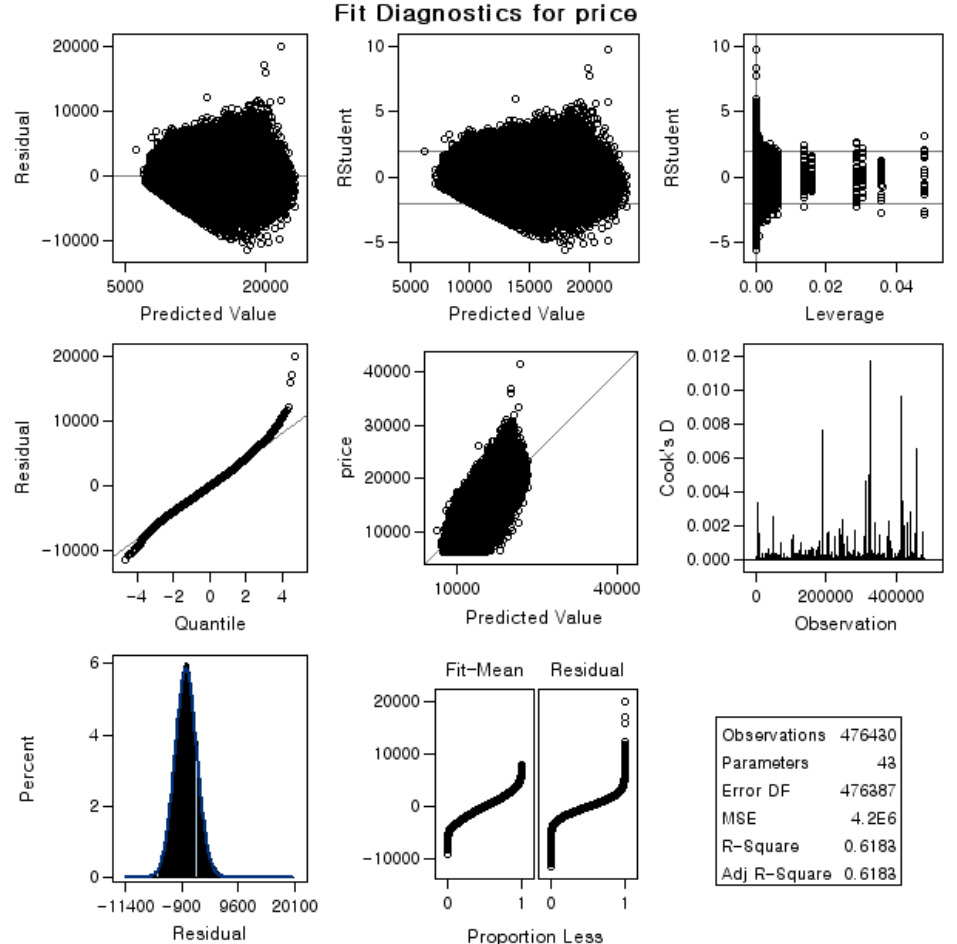
Figure 1. Fit diagnostics diagram for the model of all sexes (First model in Table